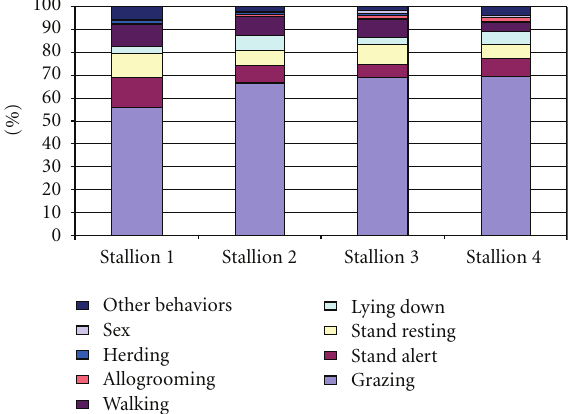
Figure 2: Time budget of the four